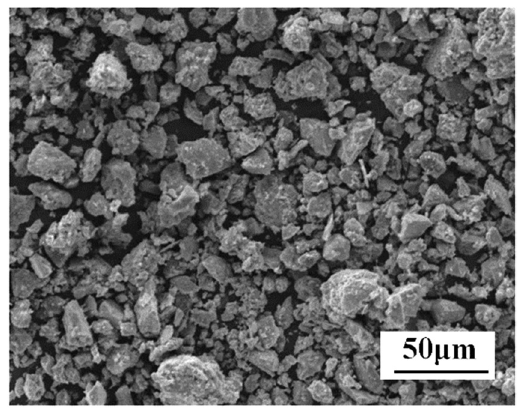
Figure 1: The micromorphology of converter